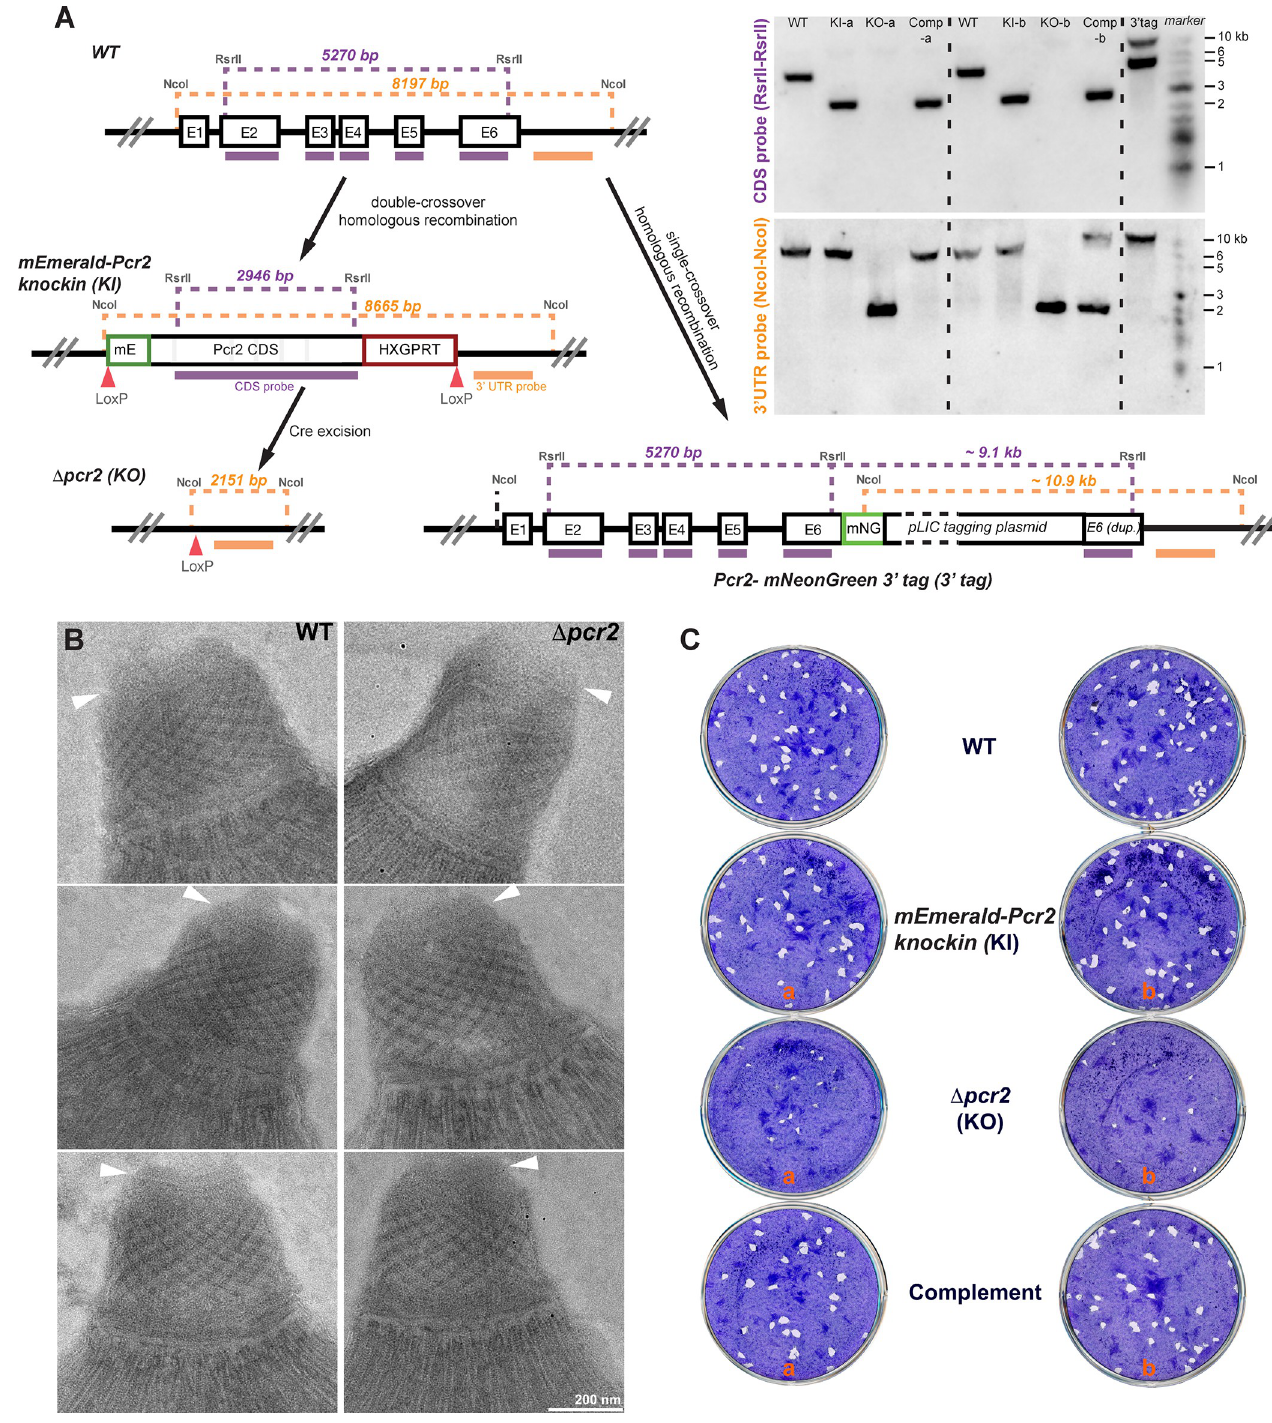
Fig 4. Generation of mEmeraldFP-Pcr2 knock-in and Δ pcr2 parasites and assessment of their plaquing efficiency. A . Left , schematic for generating mEmeraldFP-Pcr2 knock-in, Δ pcr2 parasites, and the Pcr2-mNeonGreen 3’ endogenous tagged line, and Southern blotting strategy. The positions of the restriction sites, CDS probe (purple bar) and the probe annealing downstream of the pcr2 coding sequence (“3’ UTR probe”, orange bar) used in Southern blotting analysis and the corresponding DNA fragment sizes expected are shown (also see Materials and Methods for expected hybridization patterns). Right , Southern blotting analysis of the pcr2 locus in RH Δ hx Δ ku80 (WT), mEmeraldFP-Pcr2 knock-in (KI), Δ pcr2 (KO), complemented (Comp) parasites and the Pcr2-mNeonGreen 3’ tagged line (“3’tag”). The box representing the pLIC tagging plasmid is not drawn to scale. Two sets (a and b) of independently generated knock-in, knockout, and complemented lines were analyzed. B. EM examination of the apical complex in the RH Δ hx Δ ku80 parental (WT, left column) and